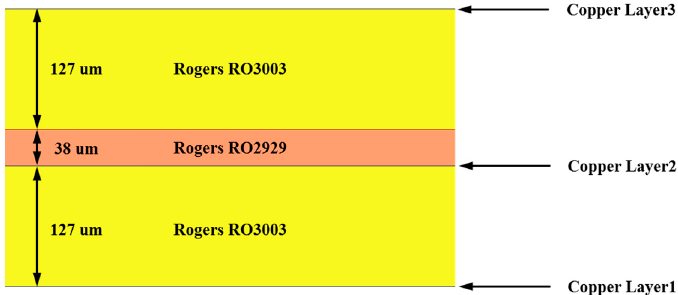
Figure 5. Side view of the three-metal-layer structure with two substrates and a bondply in the unit cell.